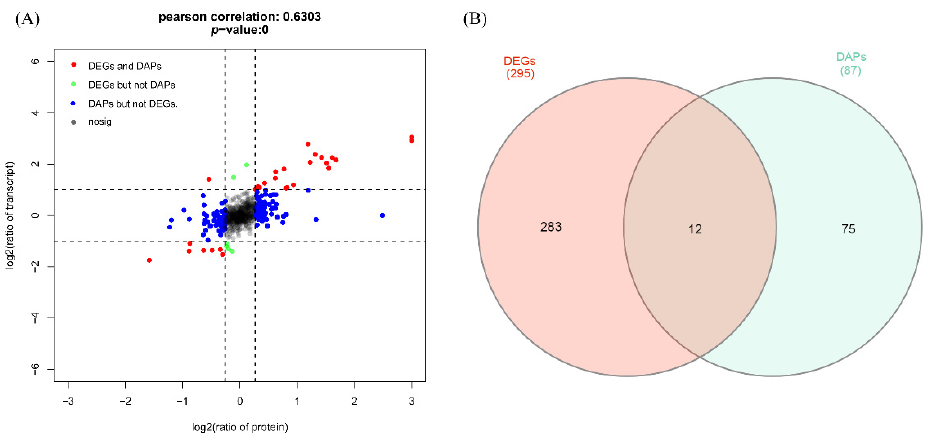
Figure 6. Integrated analysis of transcriptome and proteome. ( A ) Overall correlation between mRNA and protein changes displayed using a nine-quadrant diagram. x axis represents log 2 (fold change) of proteins and y axis represents the log 2 (fold change) of mRNAs. The correlation coefficient and p value of the transcriptome and proteome are shown at the top of the graph. Each dot represents a gene and protein. The black dots represent non-differentially expressed proteins and genes; the red dots represent the genes and proteins whose expression trends are consistent or opposite; the green dots represent the DEGs but not DAPs; and the blue dots represent DAPs but not DEGs. ( B ) Venn plot of DAPs and DEGs. The gene name and Ensemble ID for the 12 overlapped genes are shown in the “Results” section of the main text.